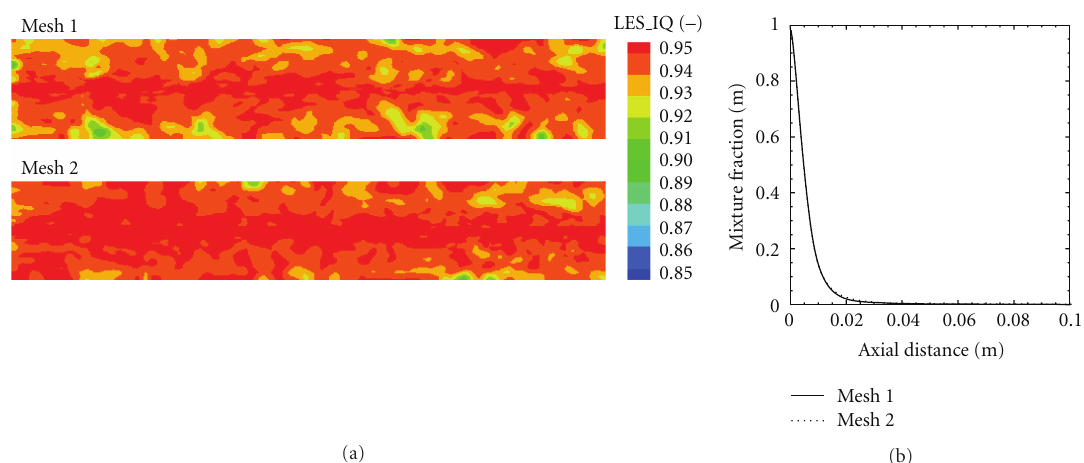
Figure 4: LES quality criteria (a) and the time averaged resolved axial mixture fraction distribution (b) Mesh 1: 150 × 70 × 48 and Mesh 2: 200 × 90 × 56 nodes in axial, radial, and azimuthal directions, respectively.